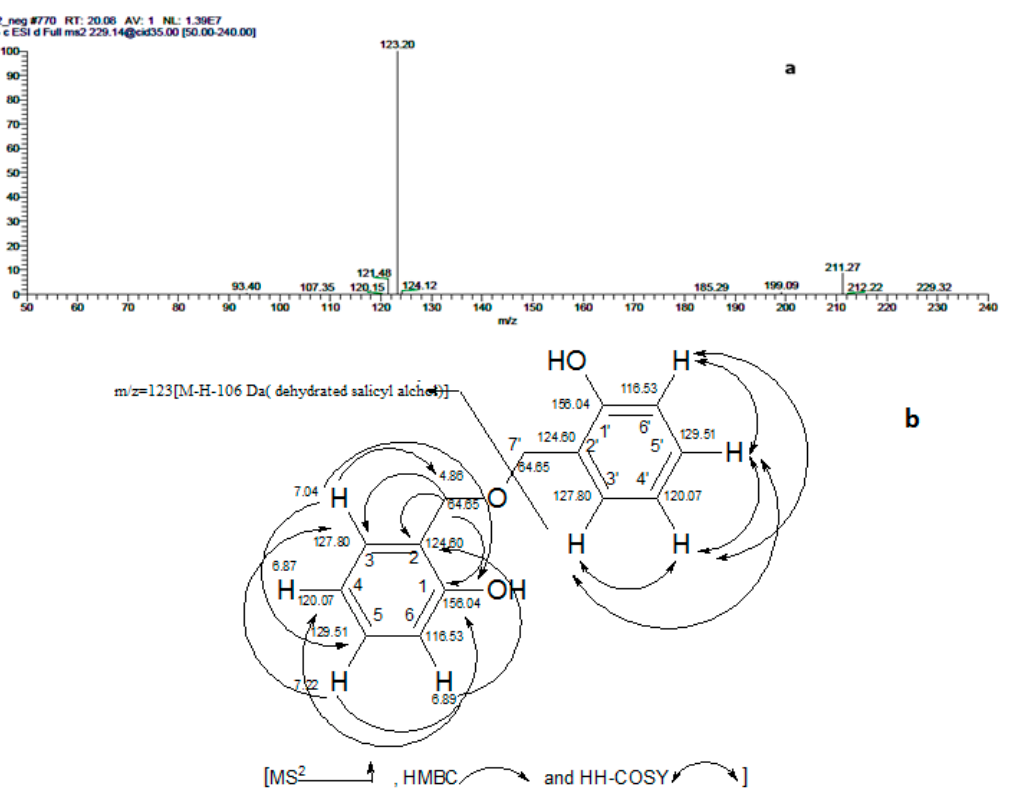
Figure 2. (a) MS 2 (mass spectrometry) of compound ( 3 ), salicyl ether at [M − H] − at m/z 229. (b) Proposed fragmentation pattern and selected nuclear magnetic resonance (NMR) correlations. fragmentation pattern and selected nuclear magnetic resonance (NMR)